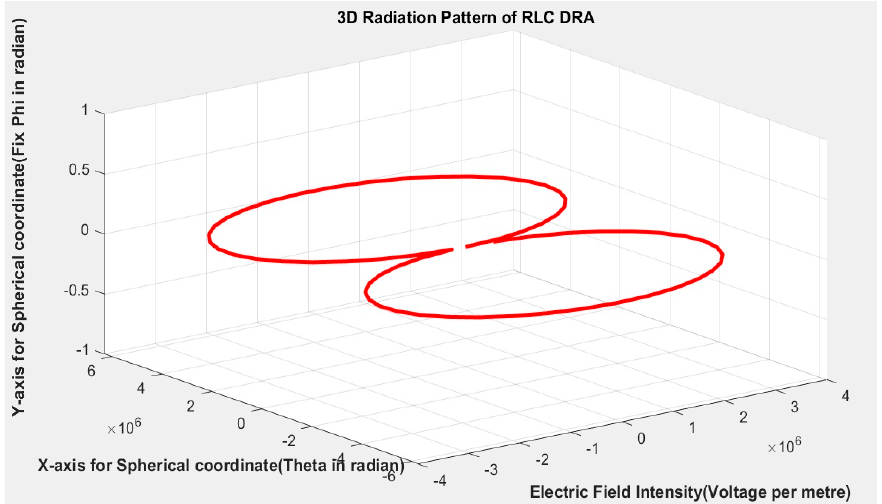
Figure 9. The Electric field configuration in the spherical coordinate of the proposed R-L-C DRA. Table 1. Parameter information of proposed multi-stacked DRA. Figure 7 and Table 2 show the hardware and tuning parameters for multi-stacked DRA for two stages. The simulation and validation results of the Multi-staked DRA(2-stage) with tuned parameters using HFSS software are quite good compared to existing